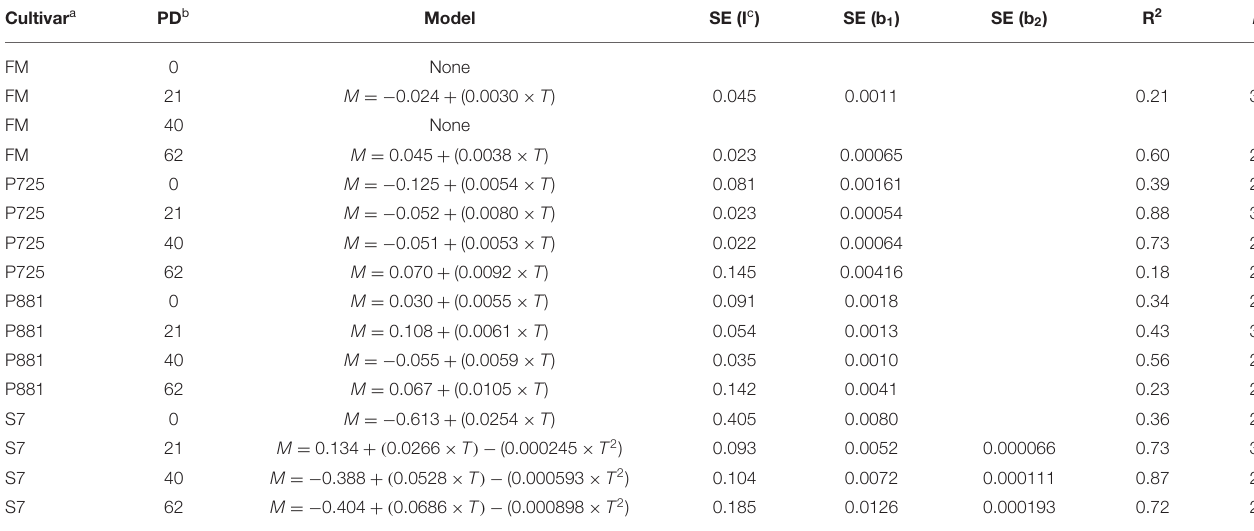
TABLE 1 | Model parameters describing mortality (M) as a function of time after planting (T) in 2021. Cultivar a